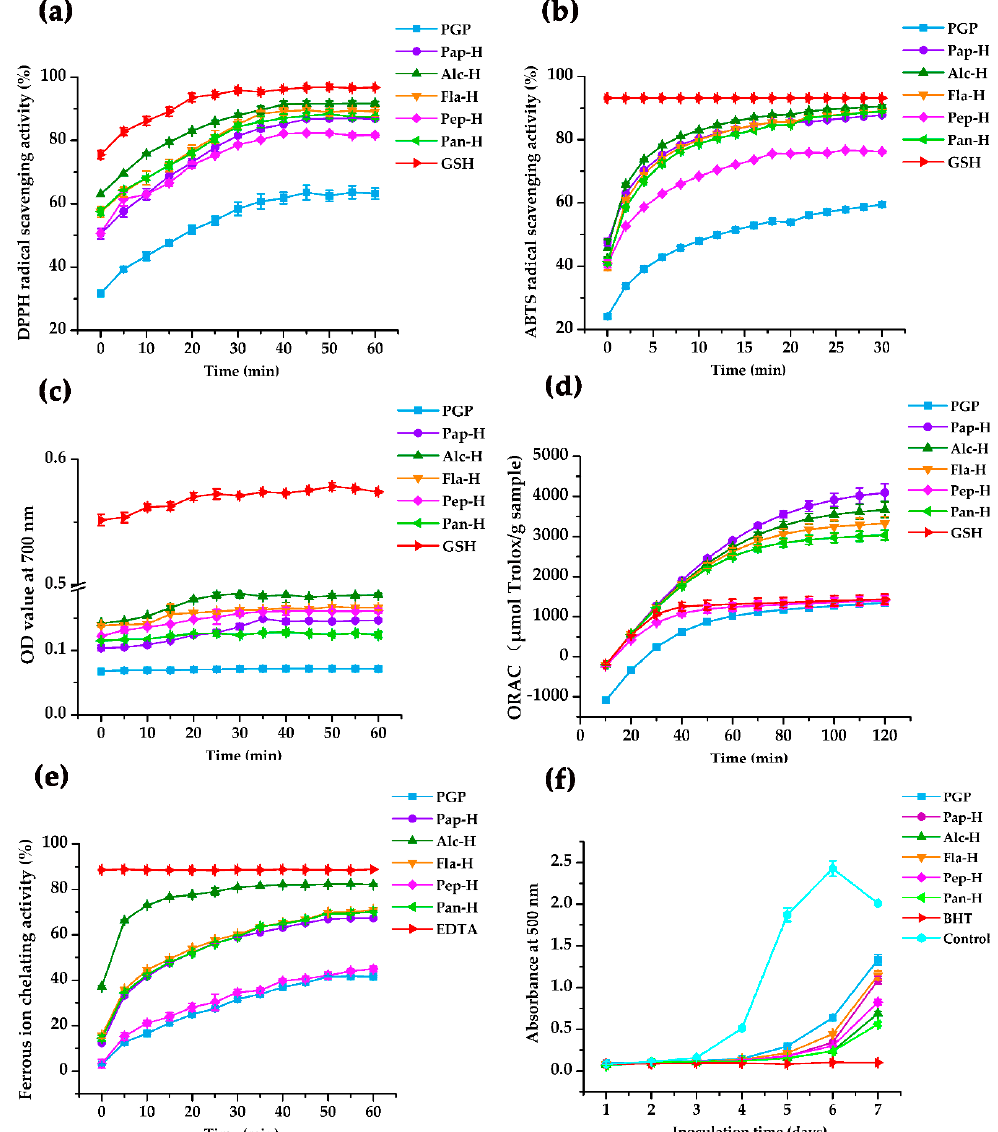
Figure 2. Antioxidant properties of PGP and its hydrolysates. ( a ) DPPH radical scavenging activity; ( b ) ABTS radical scavenging activity; ( c ) Ferric reducing antioxidant power; ( d ) Oxygen radical absorbance capacity (ORAC); ( e ) Ferrous ion chelating activity; ( f ) Inhibition of linoleic acid peroxidation. PGP, Pleurotus geesteranus protein; Pap-H, papain hydrolysate; Alc-H, alcalase hydrolysate; Fla-H, flavourzyme hydrolysate; Pep-H, pepsin hydrolysate; Pan-H, pancreatin hydrolysate. Data are expressed as mean ± SD ( n = 3).